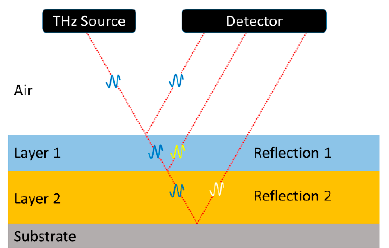
Figure 9. Schematic drawing of a substrate with two coating layers and the reflected THz beam path.